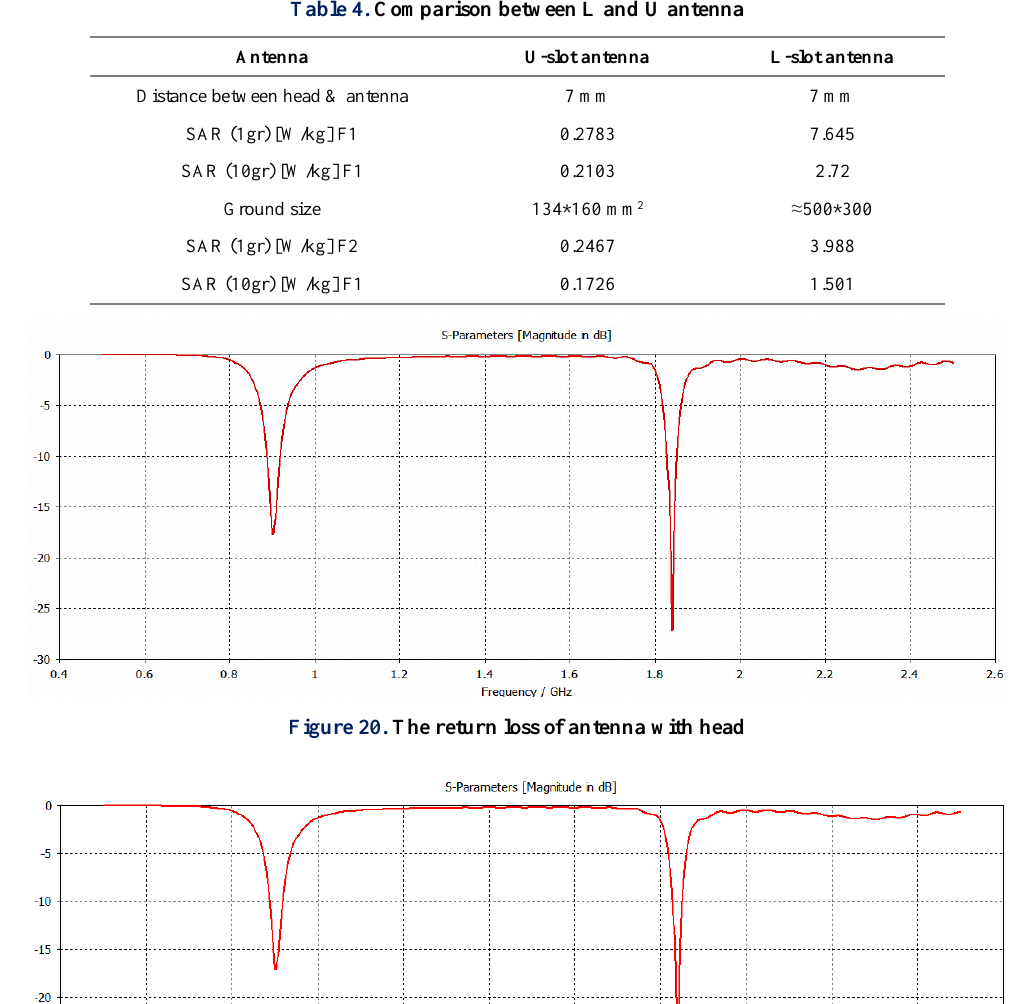
Table 4. Comparison between L and U antenna